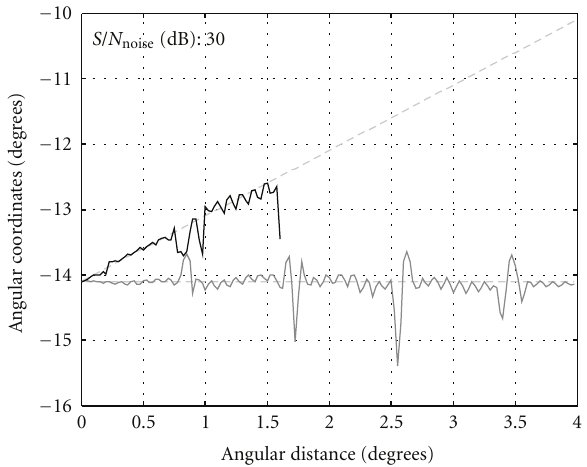
Figure 5: Histogram of polar coordinates evaluated by means of the amplitude monopulse method aided by the coherent Doppler filtration, v = 1000m/s, T p = 4ms, and S/N noise = 30dB.